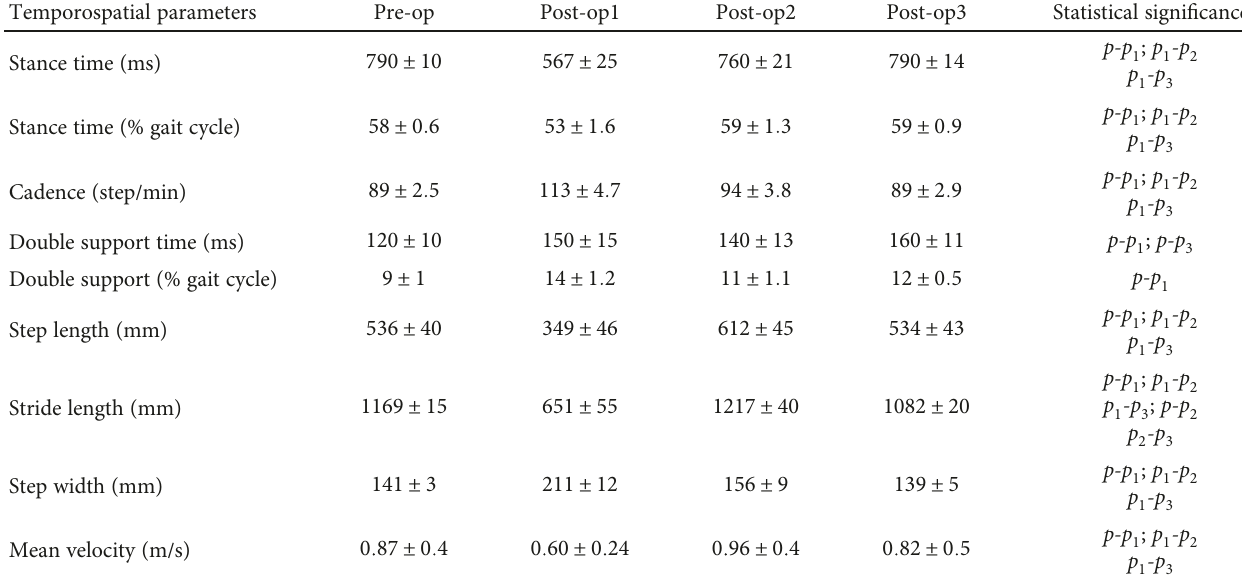
Table 1: Mean ( ± standard deviation) values of temporospatial gait parameters obtained during pre-op, post-op1, post-op2, and post-op3